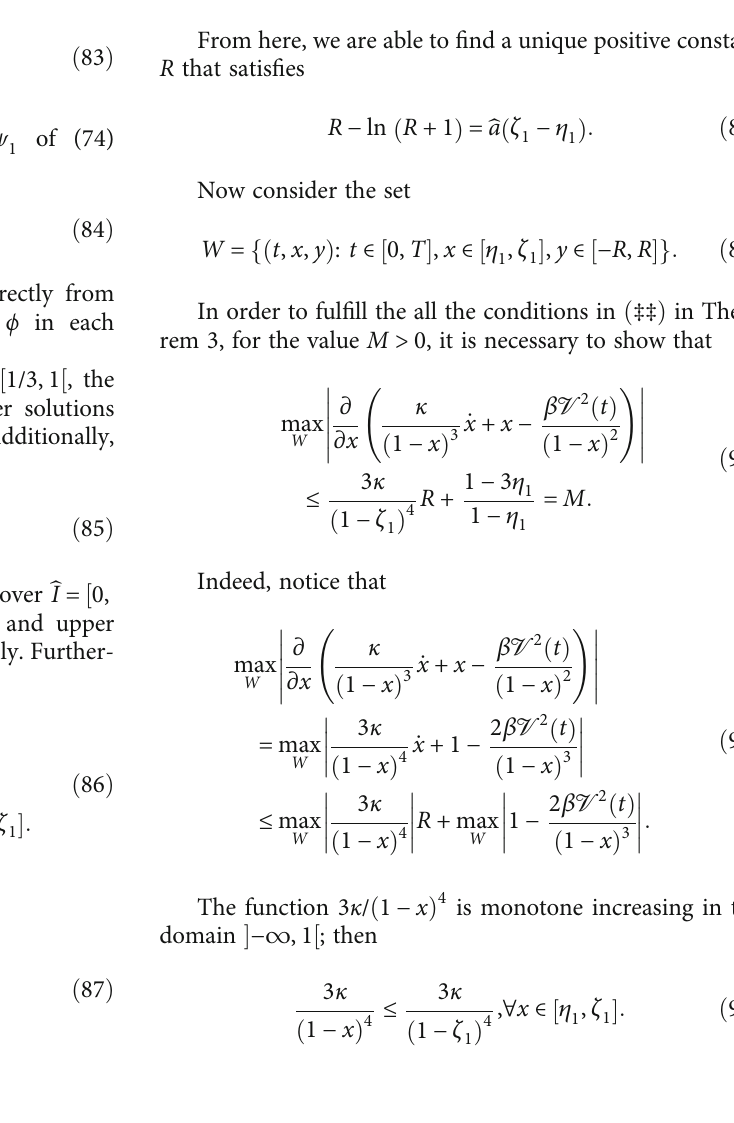
Figure 4: (a) Poincaré map of nine di ff erent solutions of (50). The periodic solution is painted in black, while the others are in red with their initial point in green. (b) Plot in blue of b ε for nine di ff erent solutions of the di ff erential equation (50). Plot in red of (73) which shows that it is an upper bound of b ε